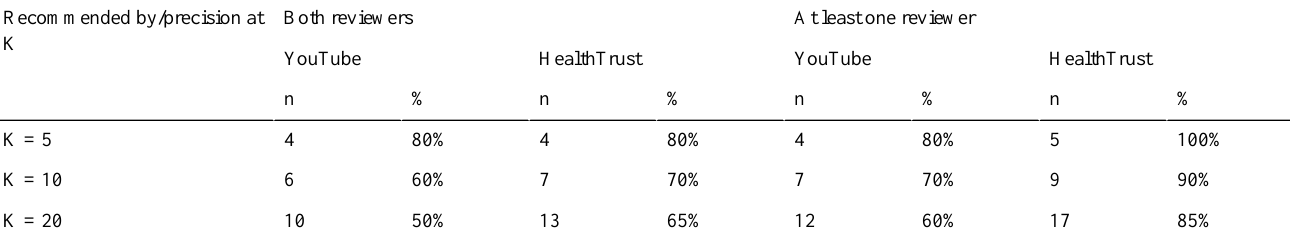
At least one reviewerBoth reviewersRecommended by/precision at